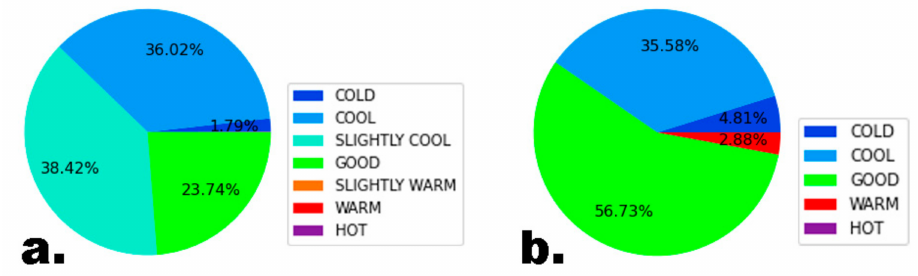
Figure 14. ( a ) PMV and ( b ) feedback values retrieved over the whole period for